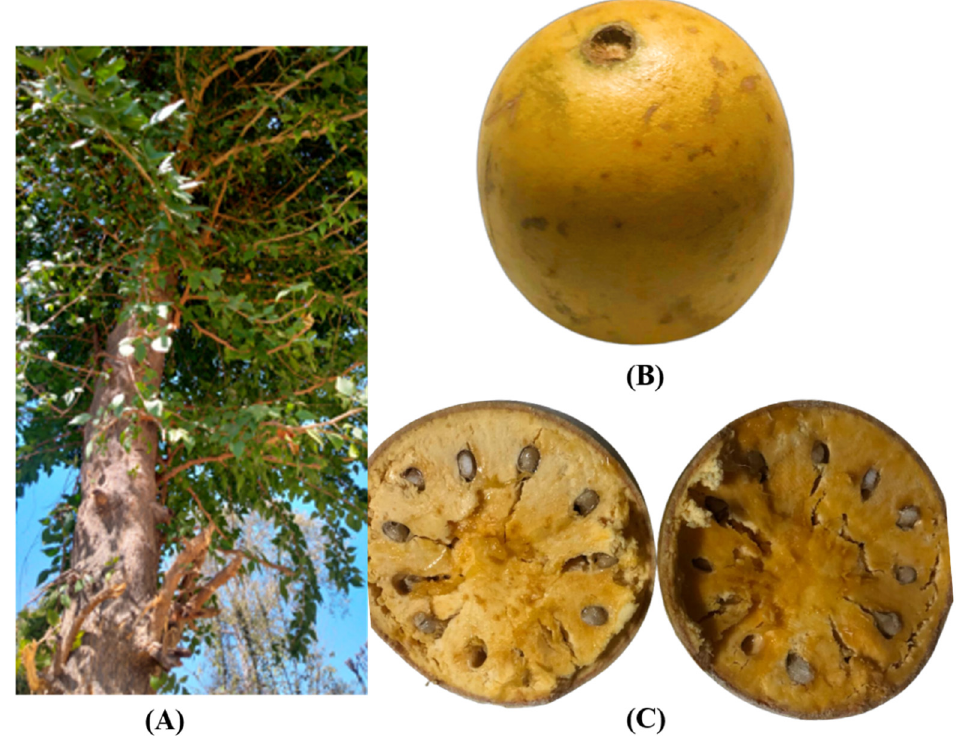
Figure 1. Aegle marmelos (L.) Correa tree ( A ) with whole fruit ( B ) and ( C ) cross-cut fruit.